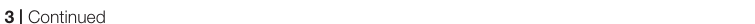
FIGURE 3 | Continued blotting using anti-CBD antibody. (B) Quantification of purified ppE2. Purified ppE2 was concentrated using 50 kD-cutoff centrifugal concentrators and analyzed by SDS-PAGE. Proteins were visualized by Coomassie Brilliant Blue staining. Bovine serum albumin (BSA) was used for comparison. (C) Size-exclusion chromatography and native-PAGE analysis of ppE2. Purified ppE2 was injected onto the equilibrated column and separated, with collection of 1.5 ml fractions. Fractions corresponding to absorbance peaks (marked with a green circle and a red box) were analyzed by 9% native PAGE and stained with Coomassie Brilliant Blue. Ferritin (440 kD), aldolase (158 kD), and conalbumin (75 kD) were used as molecular-weight standards. (D) Amino acid sequencing of ppE2 fusion protein.